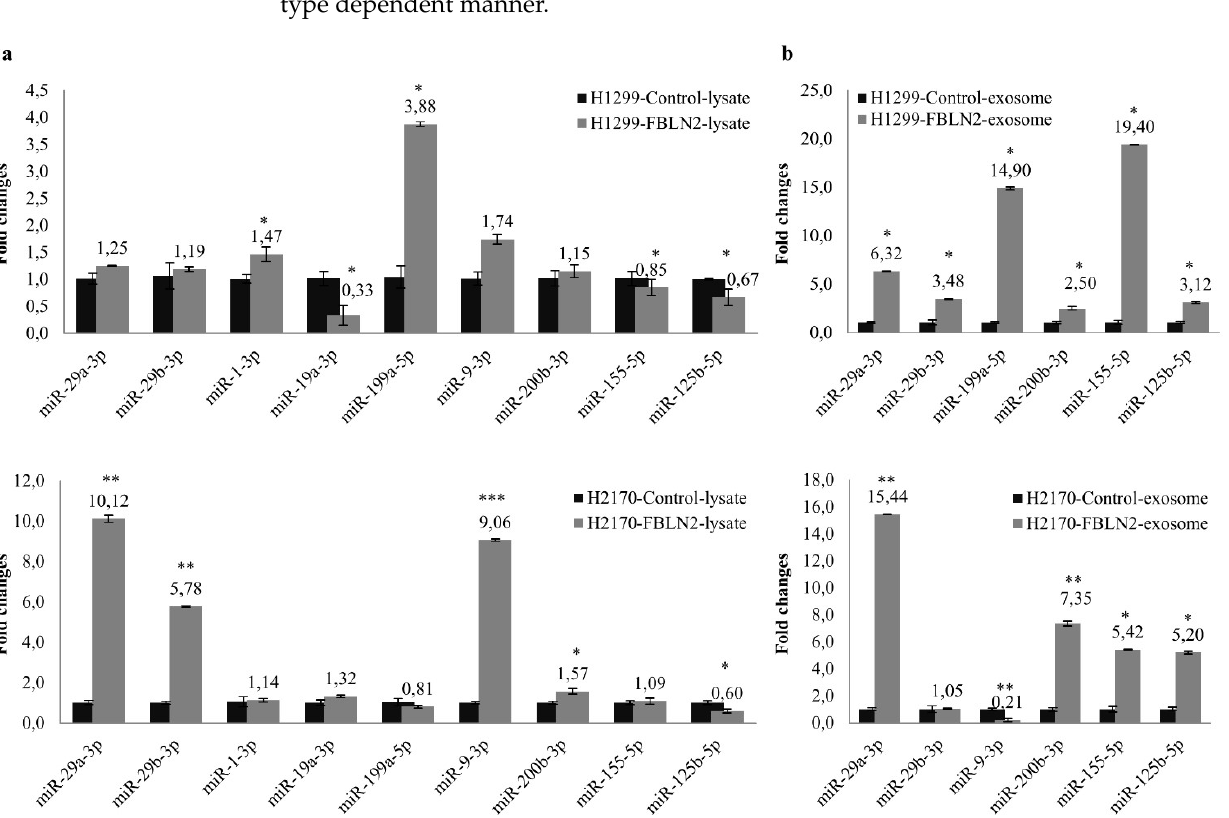
Figure 6. Effect of FBLN2 on both cell lysate and exosome-derived miRNAs. ( a ) Nine miRNAs were widely expressed in cell lysates of both H1299 and H2170 cells, but in different expression patterns. Compared to mock transfectants, miR-29a-3p, miR-29b-3p, miR-9-3p, miR-200b-3p, and miR-125b-5p were highly expressed in H2170 FBLN2 transfectants, while miR-1-3p, miR-199-5p, miR-125b-5p, and miR-21-5p were upregulated in H1299 transfectants. miRNA expression level normalized to U6 in the mock cells was set to 1.0. * p < 0.05, ** p < 0.01, *** p < 0.001. ( b ) In the analysis of exosome-derived miRNA, FBLN2 overexpression upregulated the expression of miR-29a-3p, miR-200b-3p, miR-155b-5p, and miR-125b-5p in both cell lines, and the expression of miR-29b-3p and miR-21-5p in H1299. miRNA expression level normalized to cel-miR-39 in the mock cells was set to 1.0., * p < 0.05, ** p < 0.01.